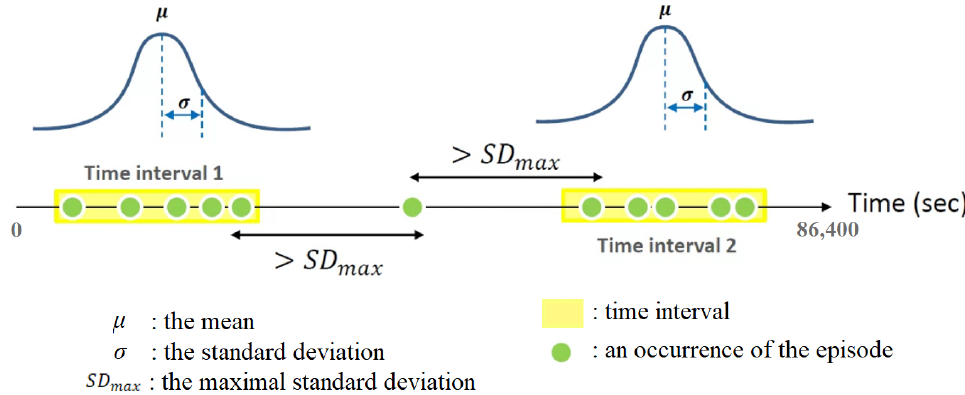
Figure 7. The concept of finding the intervals.